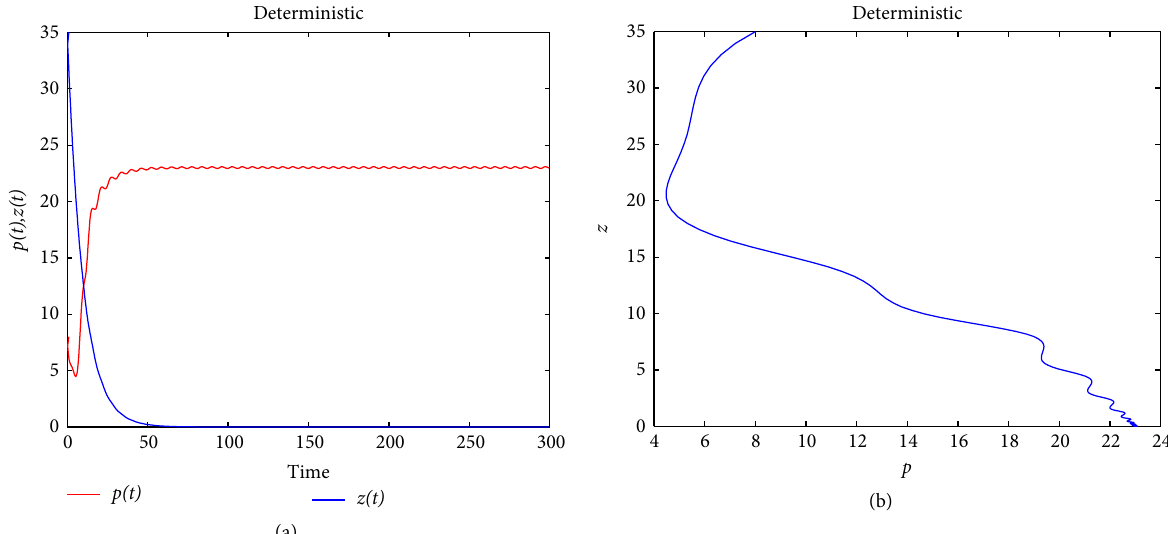
Figure 6: The solutions and phase diagram of the deterministic periodic system (72) with 𝜃(𝑡) and other parameters are taken as Eq.